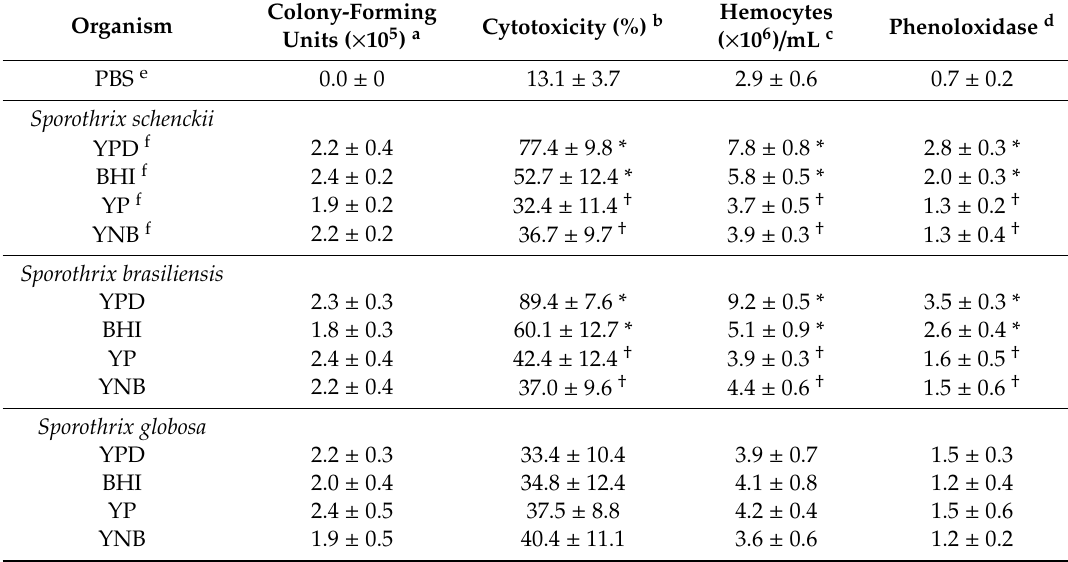
Table 1. Fungal burden, cytotoxicity, and some immunological parameters of Galleria mellonella inoculated with Sporothrix